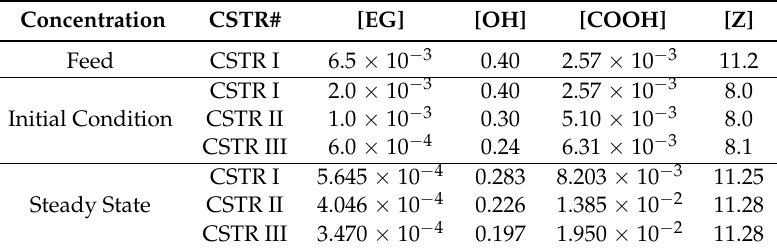
Table 2. Operating conditions and steady states a,b